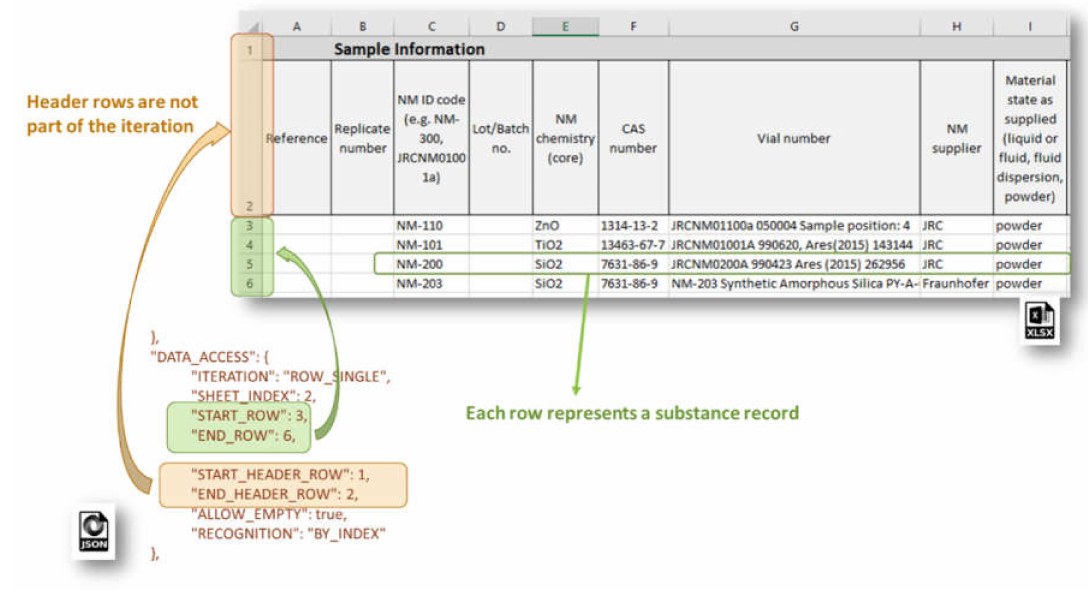
Figure 6. DATA_ACCESS configuration for iteration in the mode ROW_SINGLE.